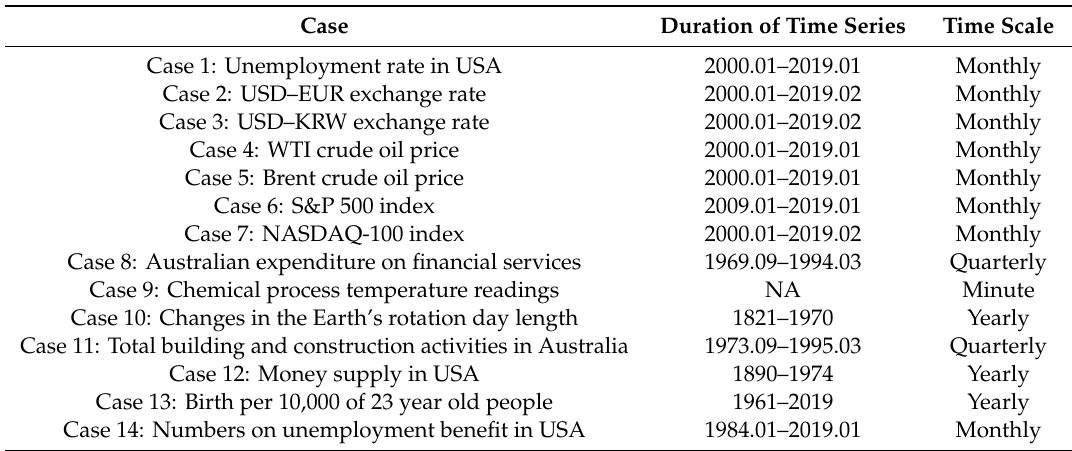
Table 1. Summary of real